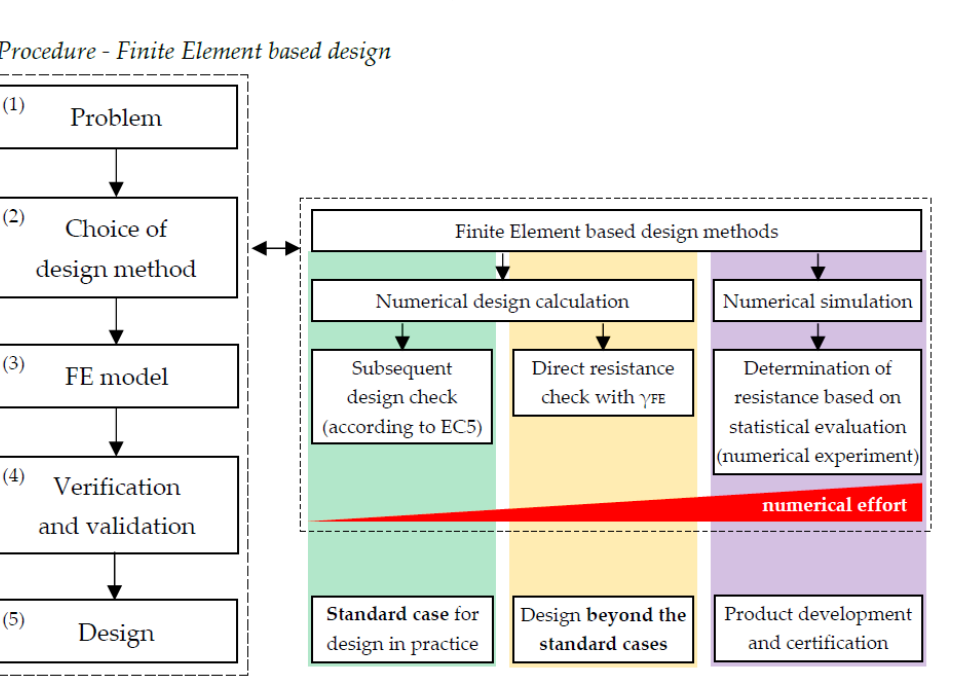
Figure 1. Procedure for the FE based design [1].